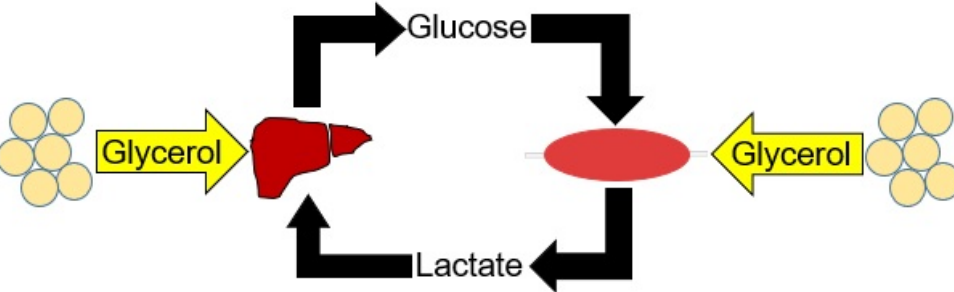
Figure 4. Glycerol from adipose tissue can contribute carbons to the Cori cycle, shown in black arrows, in two ways. The liver converts glycerol to glucose while peripheral organs, represented schematically as skeletal muscle, can convert the molecule to lactate.